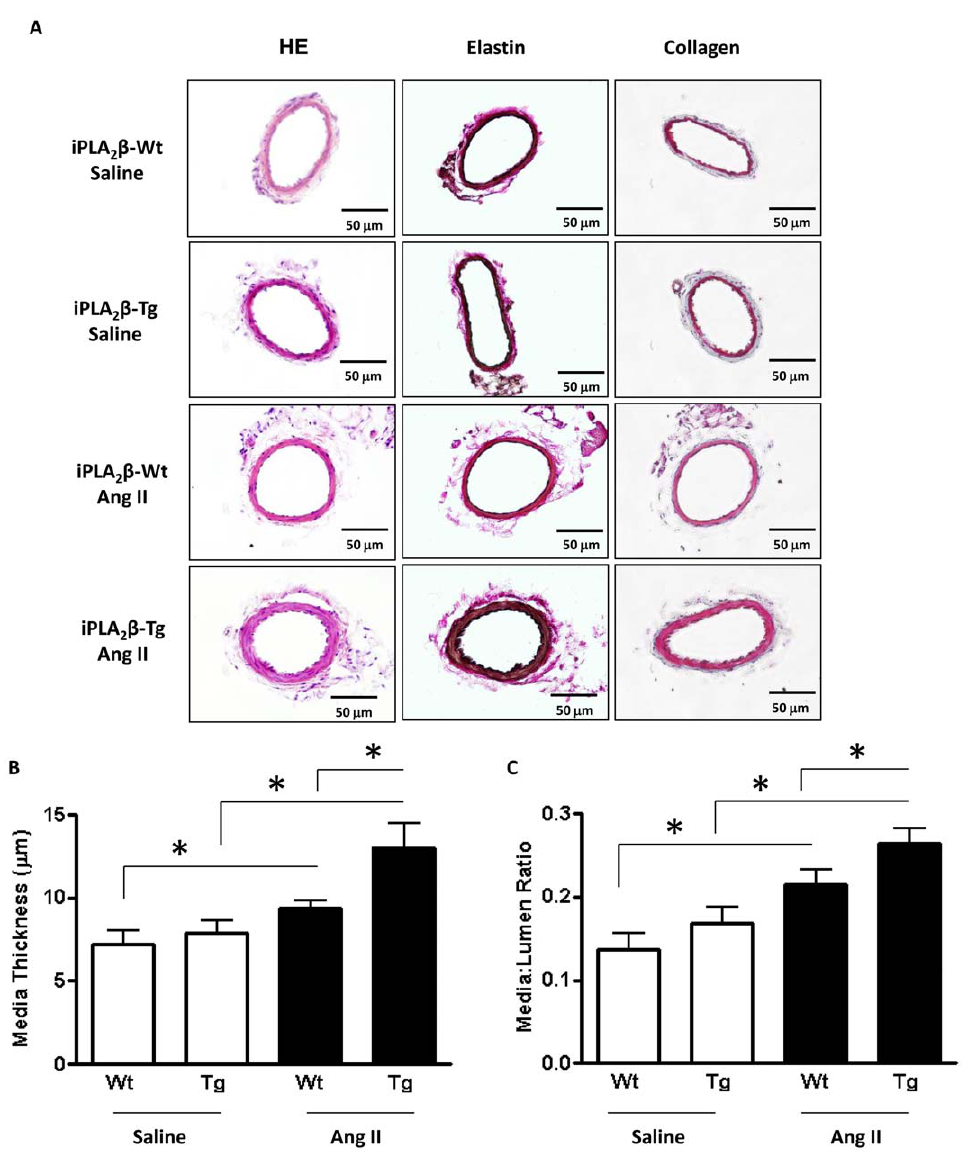
Figure 2. Exacerbated mesenteric artery remodeling in iPLA 2 b -Tg mice in response to Ang II infusion. Vascular remodeling was analyzed in embedded sections of the 2 nd order branch of mesenteric arteries from the iPLA 2 b -Wt and iPLA 2 b -Tg mice infused with saline or Ang II (500 ng/kg/ min, 14 days). Representative images of vessel sections stained with HE, elastin or collagen ( A ). The media thickness ( B ) and media:lumen ratio ( C ) were quantified. n=8, *: p , 0.05, **: p , 0.01, ***: p , 0.001 by one-way